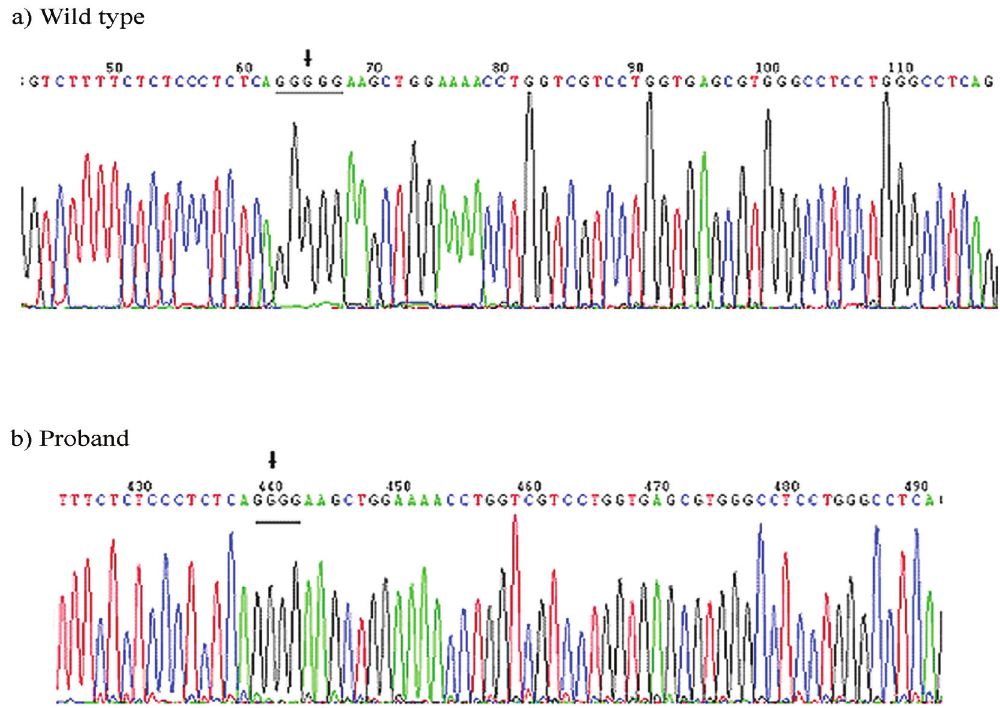
Figure2 - Sequenceanalysisof COL1A1 fromawild-typecontrolandthesameDNAregionfromtheprobandcontainingthemutation.DNAsequencing was initiated in the ninth intron and extended into the tenth exon. (A) Genomic DNA sequence of the control wild-type allele. (B) DNA sequence of a COL1A1 clone from the proband. The DNA sequence of the same region from the mother was identical to the proband (data not